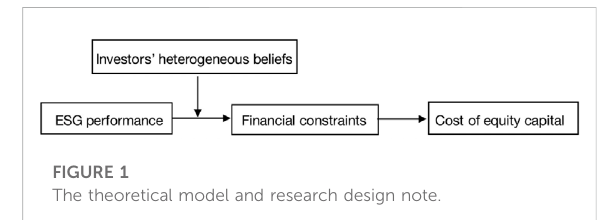
FIGURE 1 The theoretical model and research design